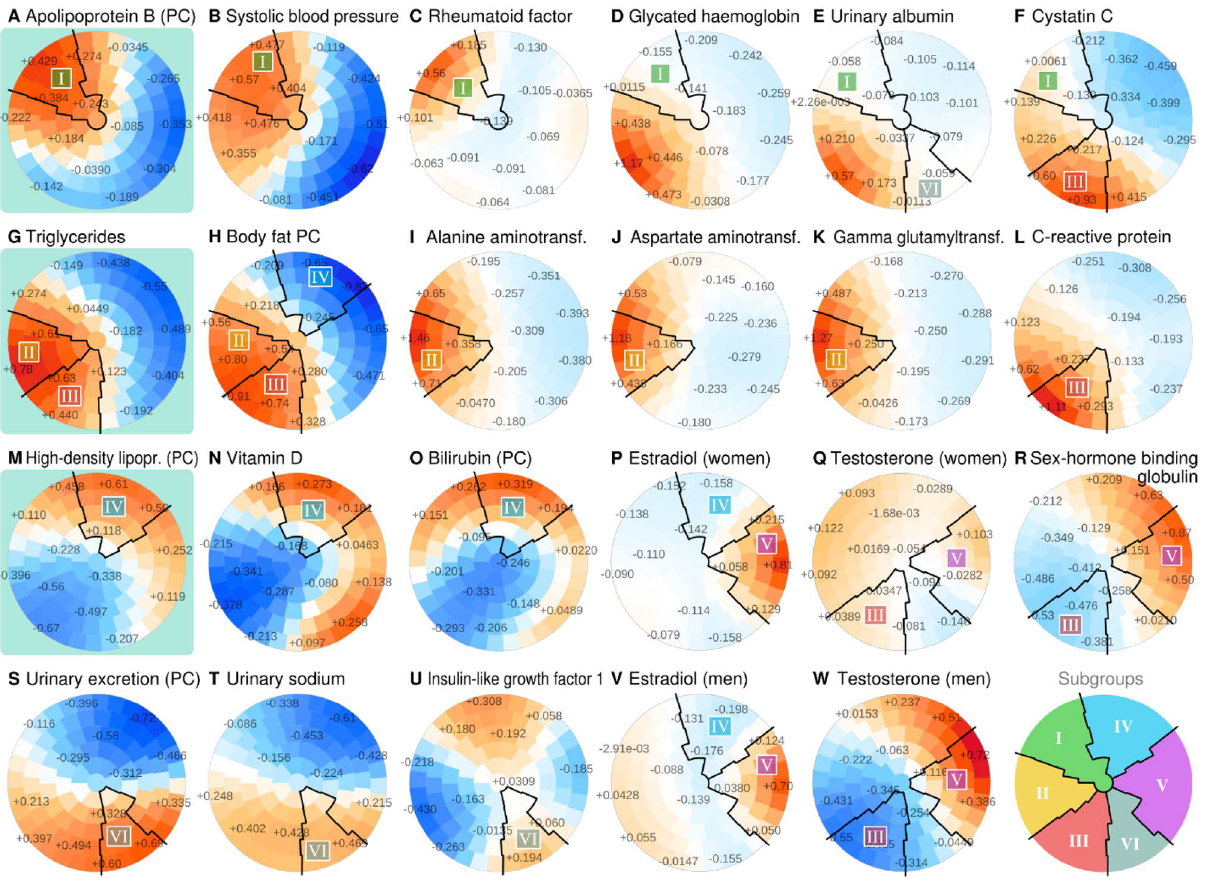
Figure 3. The SOM subgrouping procedure applied to the UK Biobank. In each plot, the same participants reside in the same district. The colors of the districts indicate the regional deviation from the global mean, with color intensity adjusted according to how much the variable contributed to the structure of the map. The numbers on the districts indicate the smoothed mean Z-score of the